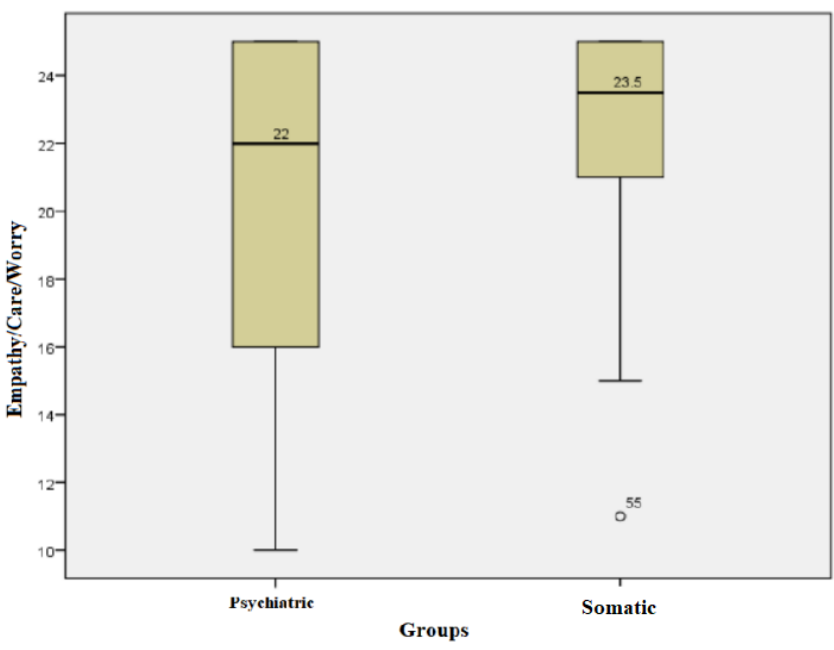
Figure 3. Empathy/care/worry field for both groups. For each subject, the score for the education/learning field was calculated. The subjects in the somatic group had values of this score between a minimum of 4 and a maximum of 20, with an average +/ − SD = 16.04 +/ − 3.77 and a median of 17. The subjects in the psychiatric group had values of this score between a minimum of 5 and a maximum of 20, with an average +/ − SD of 13.78 +/ − 3.93 and a median of 13. Kolmogorov − Smirnov tests showed that the values for this field followed non-parametric distributions in both groups. The Mann − Whitney test showed that the median values in the somatic group were statistically significantly higher compared with that of the psychiatric group values (U = 816.50, p = 0.03) (Figure 4).